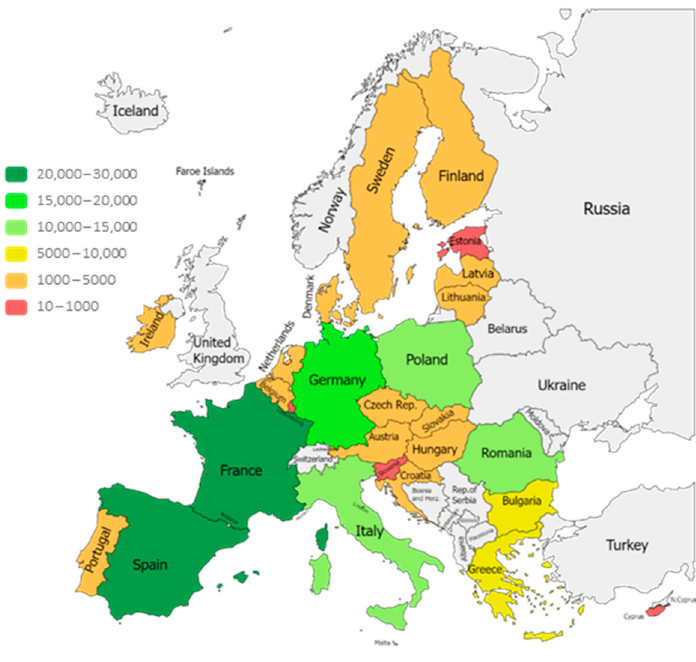
Figure 1. Map of EU UAA 2020 distribution (thousand hectares). Source: Authors’ calculation and representation, according to Eurostat (2020)